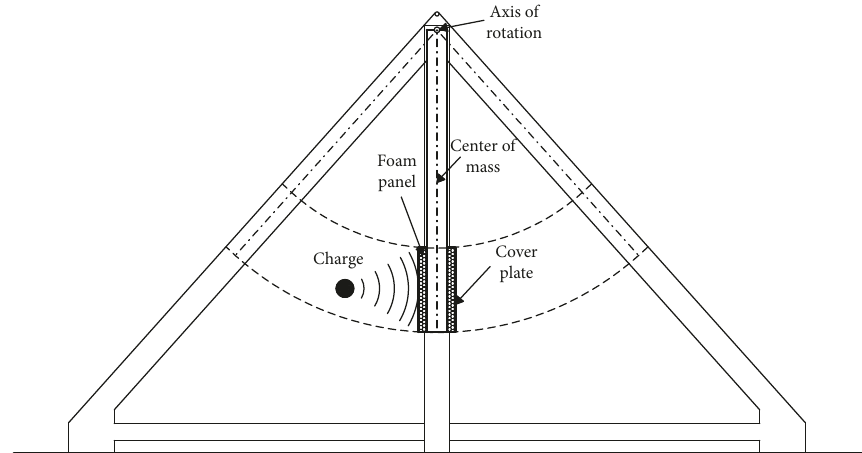
Figure 5: Field blast pendulum system